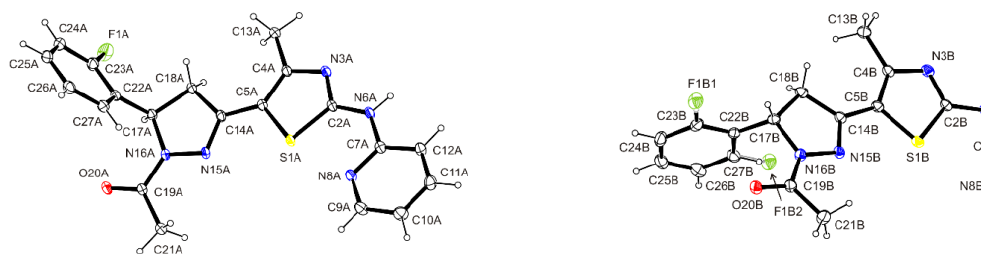
Figure 4. π ··· π Interactions between pyridine-2-yl ( Cg 2) and 2-flourophenyl ( Cg 2) systems. Hydrogen atoms have been omitted for clarity. Symmetry codes: (i) 1 − x , 1 − y , 1 − z , (ii) 2 − x , 1 − y , 1 − z . Table 1. Hydrogen-bond geometry (Å, °) for ( 3 *DMF).